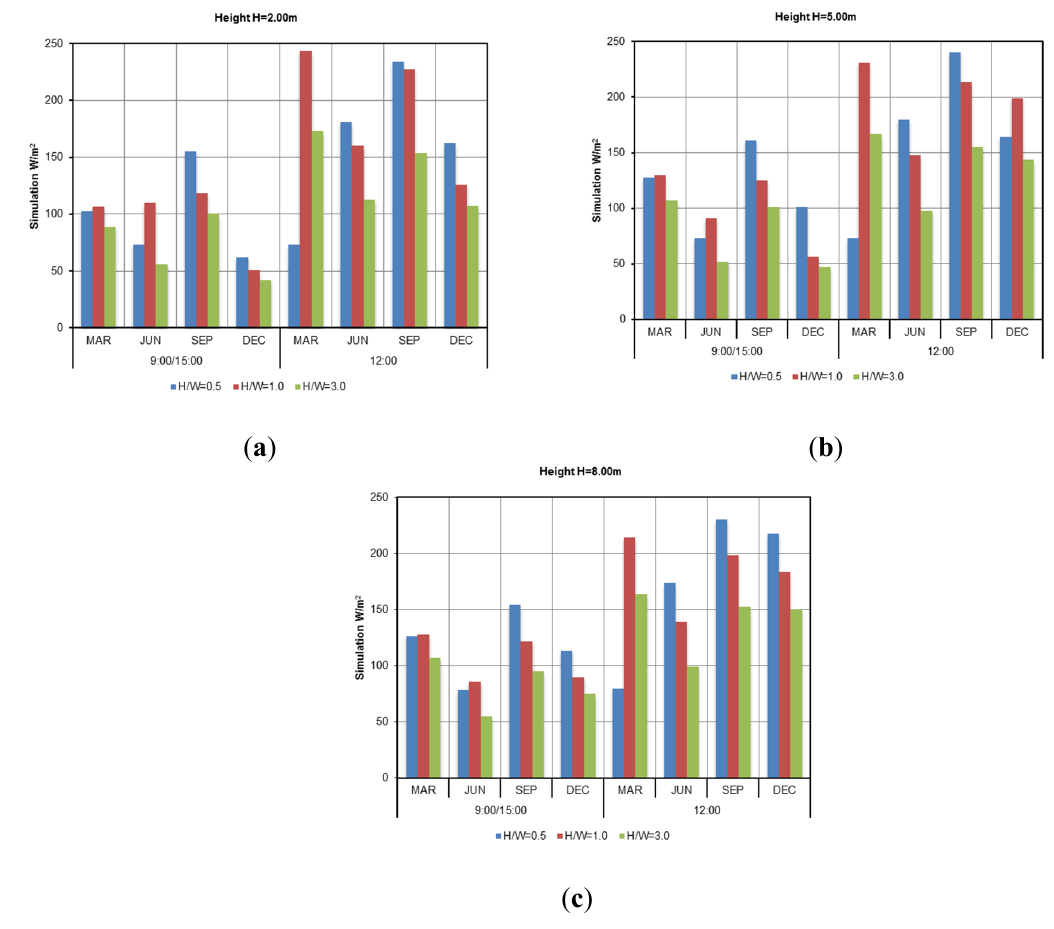
Figure 14. Results from the parametric analysis. South façade, Seville. ( a ) Point at height H = 2.00 m; ( b ) Point at height H = 5.00 m; ( c ) Point at height H = 8.00 m.